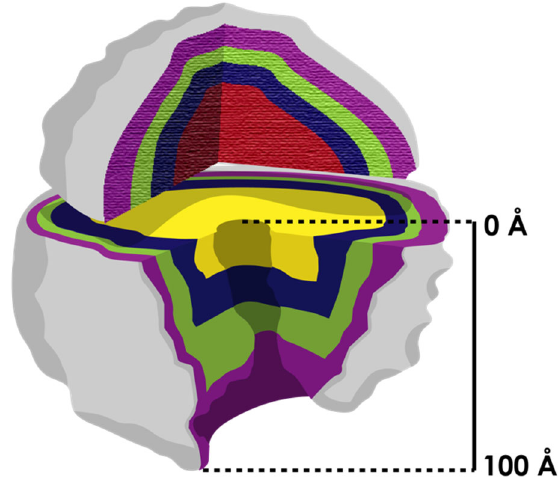
Figure 4. The ribosome is conceptualized as an onion (with layers indicated in different colors) that grows from the center (the most ancestral part). The two subunits evolved independently (most inner shell in different color) at first, and the process of coevolution occurred later when they associated. According to Williams [36], the only structure that evolved continuously on the ribosome was the exit tunnel (it extends over 100 Å from the PTC to the vestibule). Other authors [58] have demonstrated that differences in the exit tunnel increase among organisms from the center to the surface.